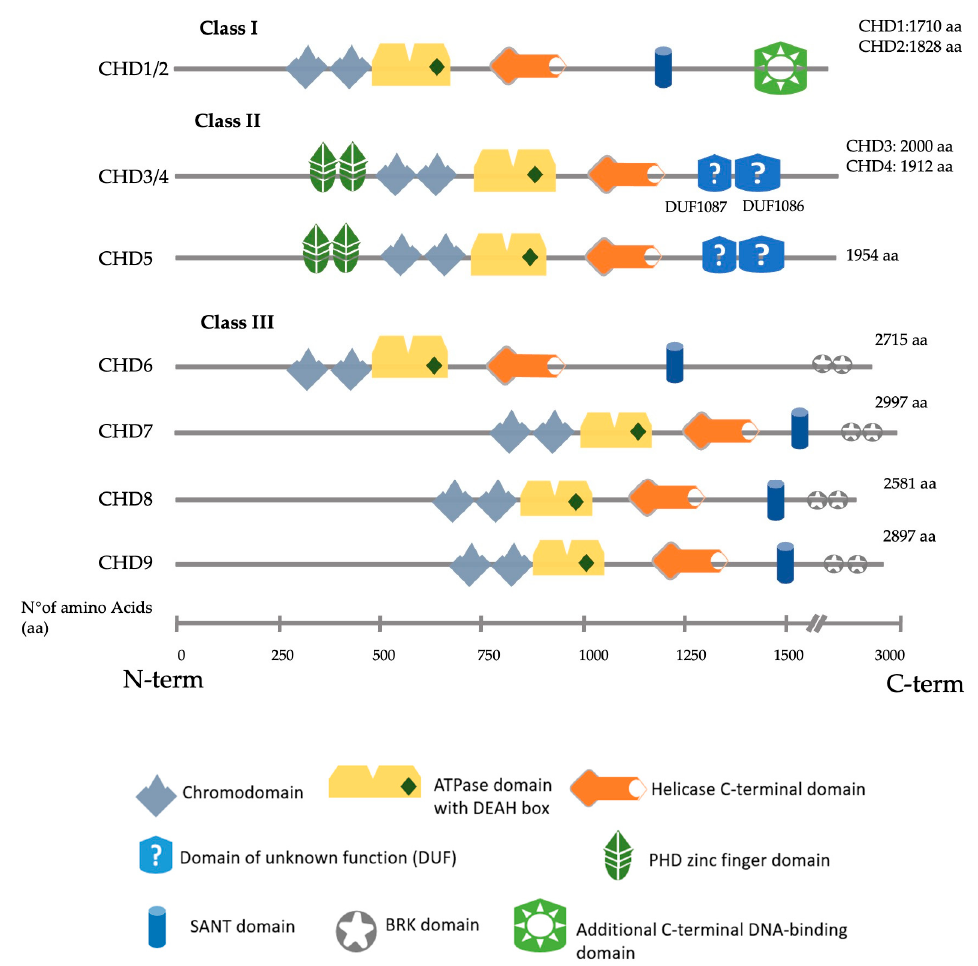
Figure 1. Schematic representation of all nine human CHD proteins divided by their class, showing the approximate position of the main predicted domains, as described in Uniprot, SMART and InterPro [14–16].